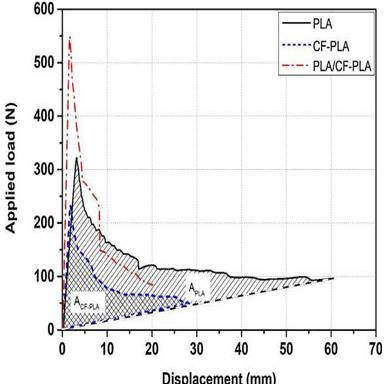
Force-displacement curves from the DCB tests of PLA, CF-PLA and PLA/ CF-PLA specimens. APLA and ACF PLA refer to the area under the corresponding force-displacement curves.